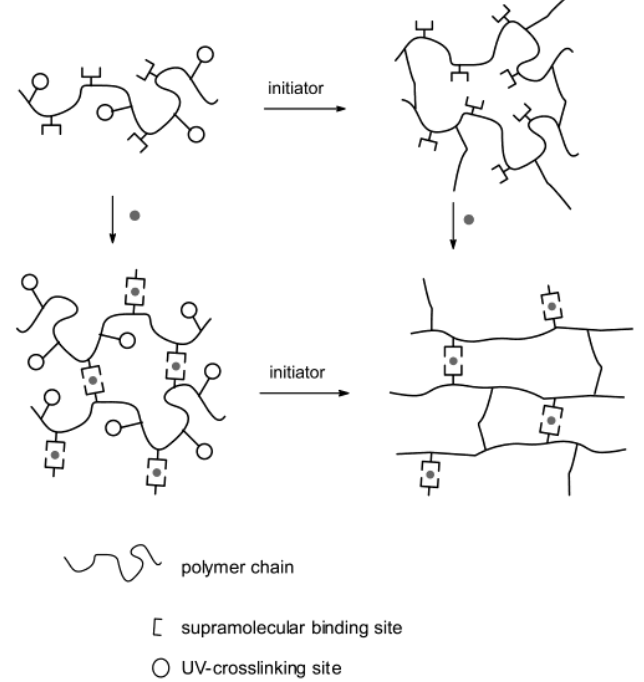
Figure 16. Scheme of two-stage formation of covalent and supramolecular crosslinks during terpolymer synthesis. Reprinted with permission from [178]. Copyright (2003) American Chemical Society.